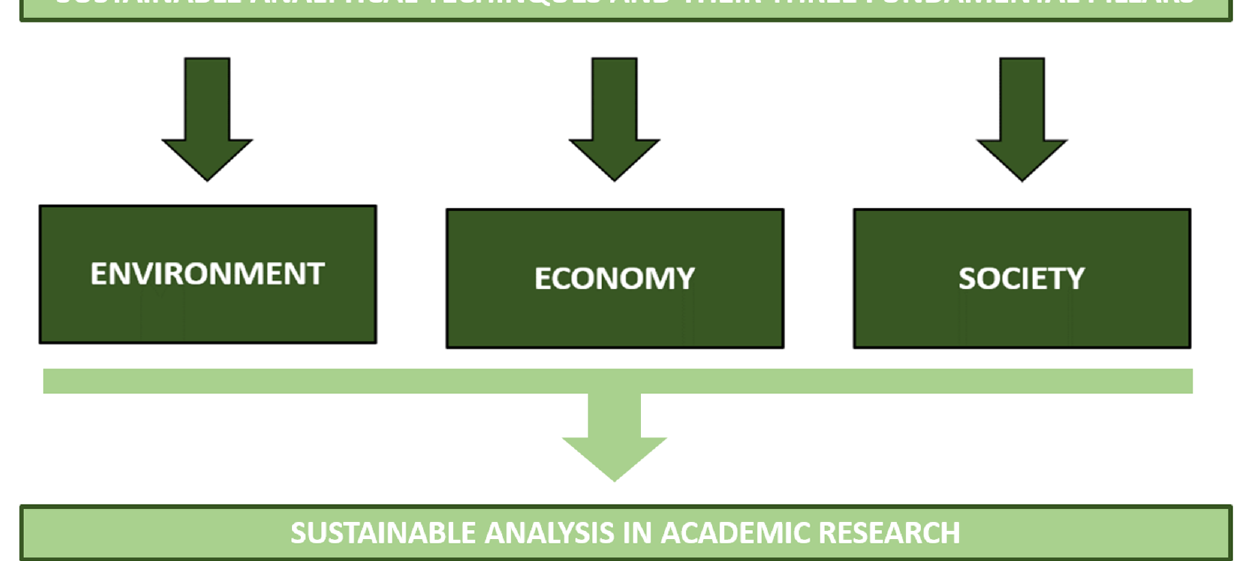
Figure 1. Sustainable analysis in academic research starts from sustainable analytical techniques that have to take into consideration three fundamental pillars: environment, economy, and society.